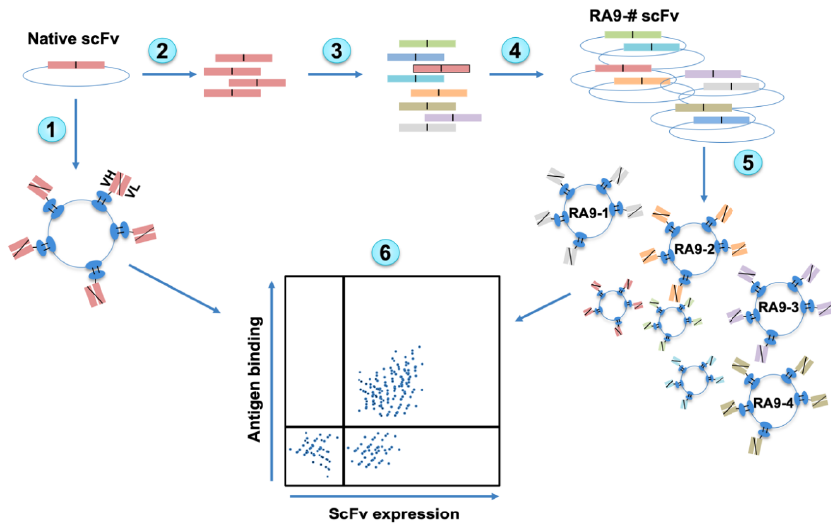
Figure 1. Overview of Yeast Surface Display (YSD) platform design. Native antibody scFv is